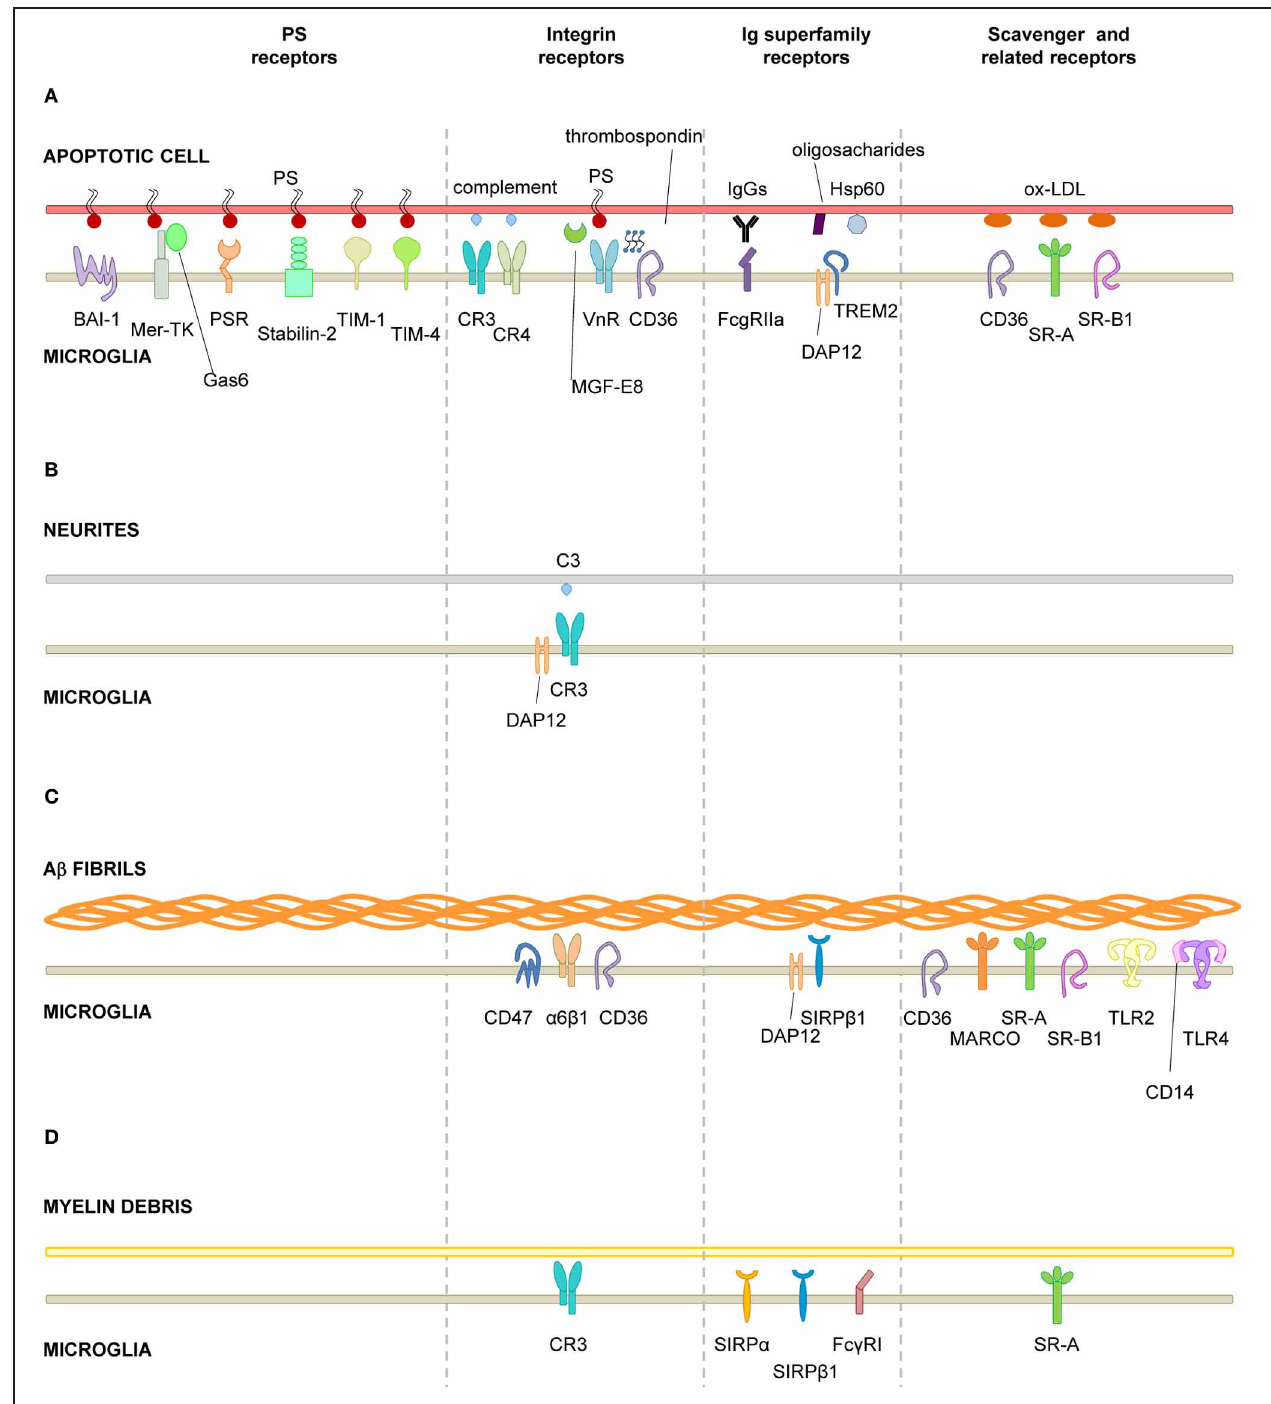
FIGURE 2 | Receptors involved in microglial phagocytosis of endogenous structures. (A) , Apoptotic cells; (B) , Neurites; (C) , A β aggregates/fibrils; (D) , Myelin debris. Receptors have been classified into major functional/structural groups: phosphatidylserine (PS) receptors, integrin receptors, Ig superfamily-receptors, and scavenger and related receptors. For more details on the receptors, refer to Table 1 . For receptors involved in the recognition ofnecrotic cellsandmicrobes, refer tothemaintext. Abbreviations: A β , β -amyloid protein; BAI-1, brain angiogenesis inhibitor 1; CR, complement